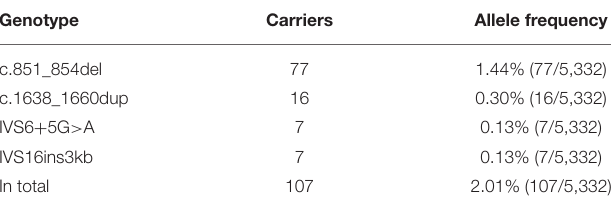
TABLE 3 | The four prevalent SLC25A13 mutations detected in Jiangmen.